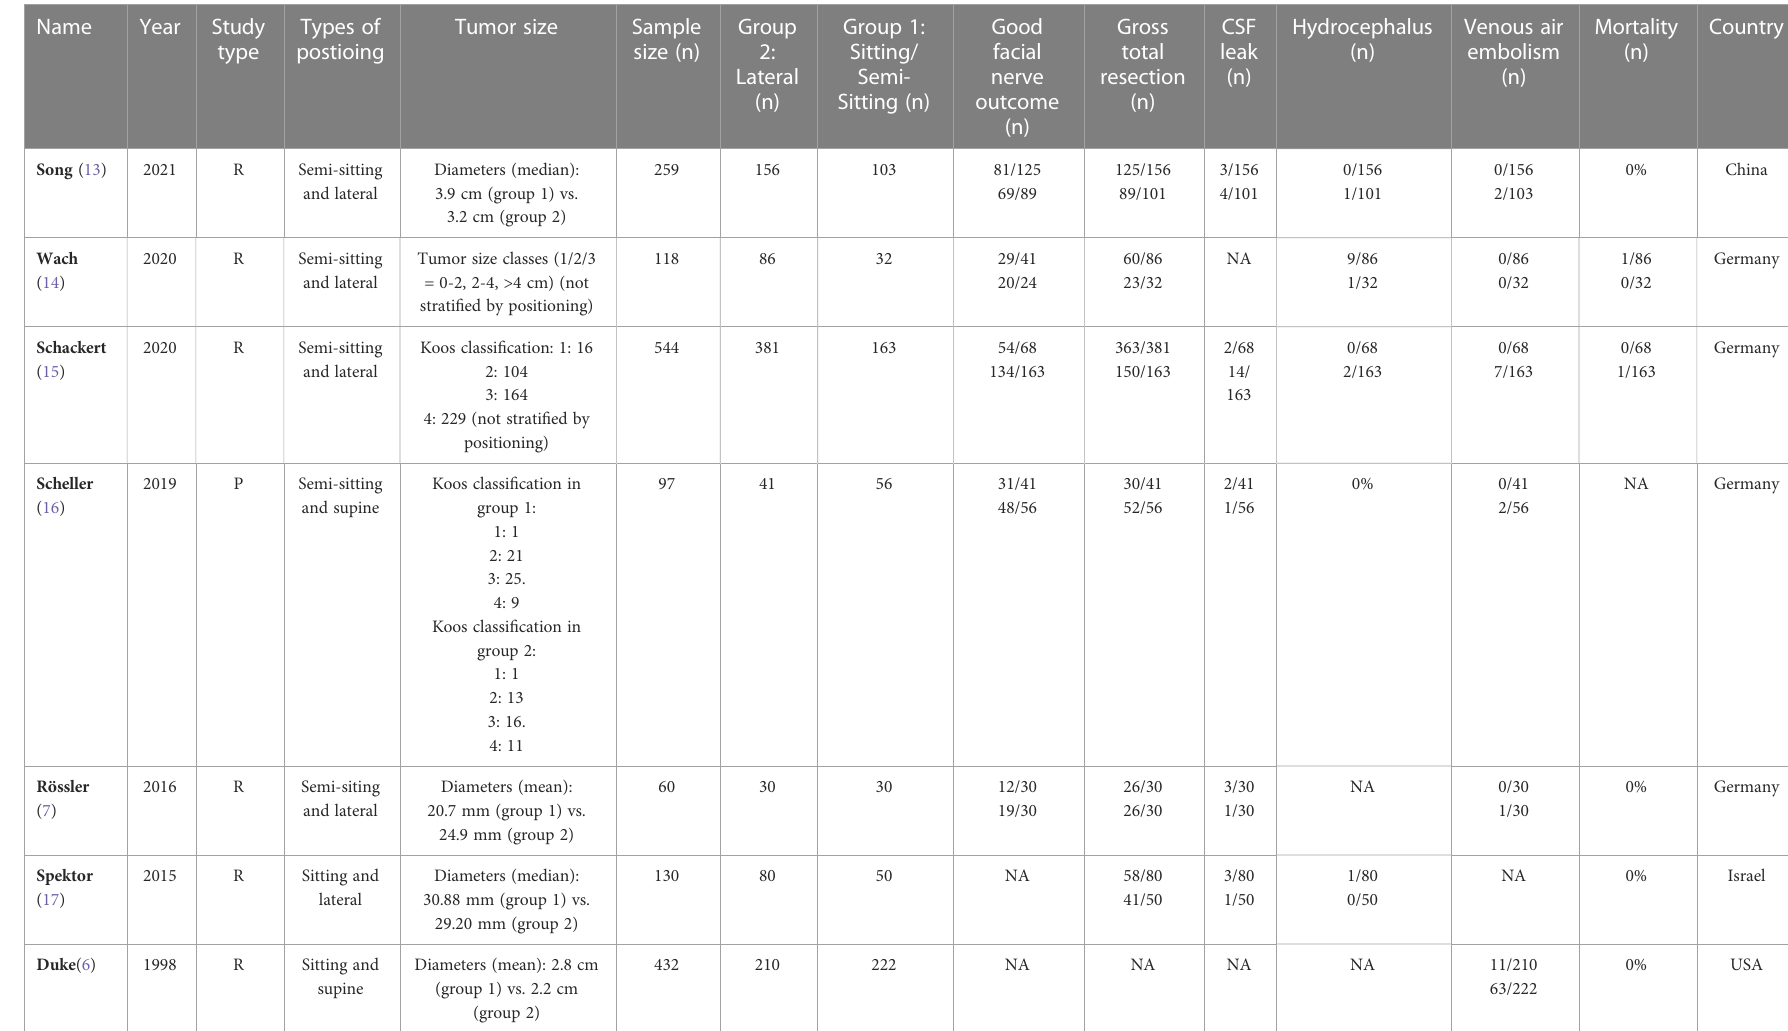
TABLE 1 Major characteristics of studies included in the present meta-analysis.